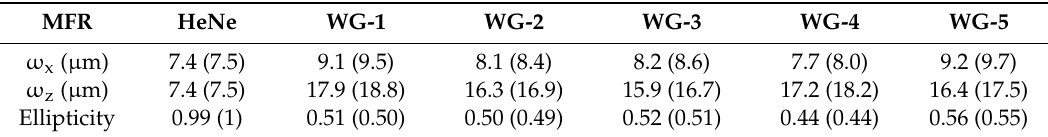
Table 1. The experimental (simulation) near-field mode field radii (MFR) of the five double-track waveguides inside CaF 2 along the horizontal (x) and vertical (z) axes and for the injected HeNe beam. MFR HeNe